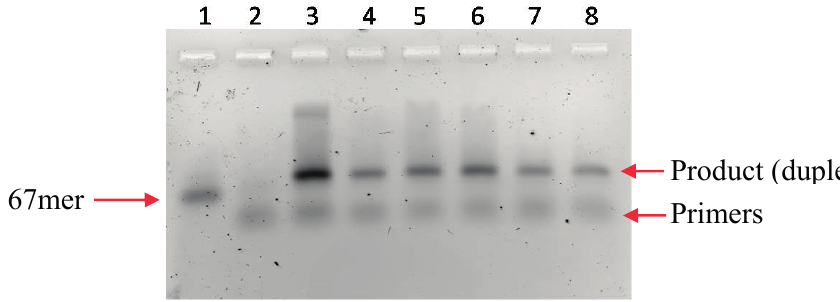
Figure 4. Agarose gel analysis of PCR products obtained with Vent (exo-). Total reaction mixture (20 μ L) consisted of 1 pmole T3 , 150 pmole of each primer, 0.2 mM of each dNTP and 2 unit of enzyme. Reactions were performed at 1X commercial thermopol buffer with a final Mg +2 concentration of 7 mM. Lane 1: 67mer DNA template; lane 2: no